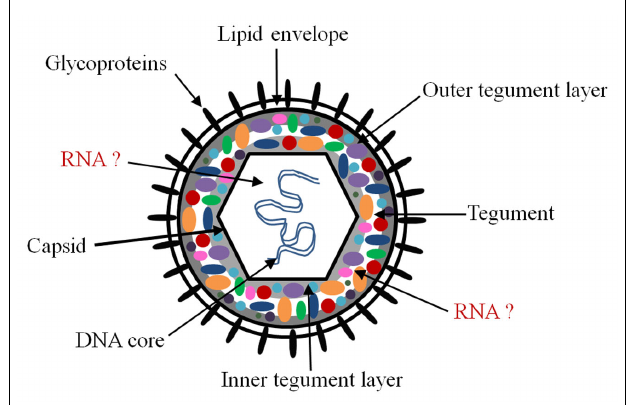
FIGURE 2 | Cascade of herpesvirus gene expression. Herpesvirus genes are expressed in a coordinated temporal cascade: immediate early ( α ), early ( β ).There are two subclasses of late gene expression that have been defined, although they are expressed concurrently: leaky-late ( γ 1) is not dependent on DNA synthesis, and true late ( γ 2) is dependent on DNA synthesis. Packaging of RNAs in the virion allows immediate expression upon virus entry in the absence of transcription, and thus adds an additional element in the highly regulated cascade of gene expression of